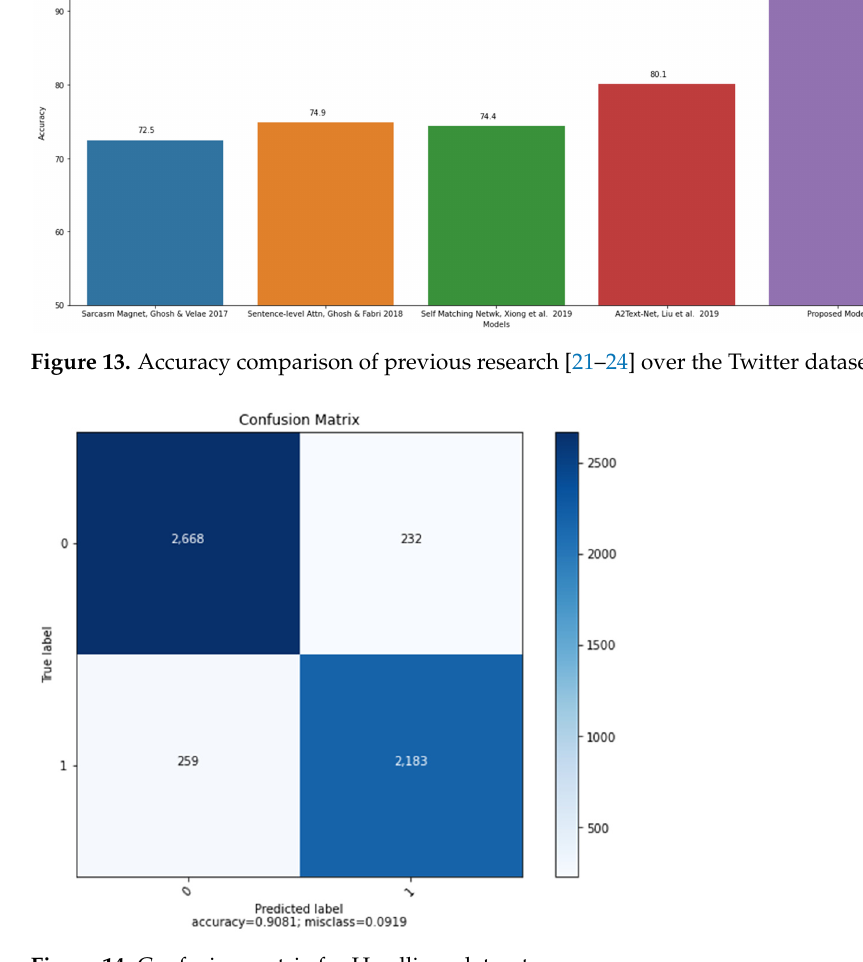
Figure 14. Confusion matrix for Headlines dataset.